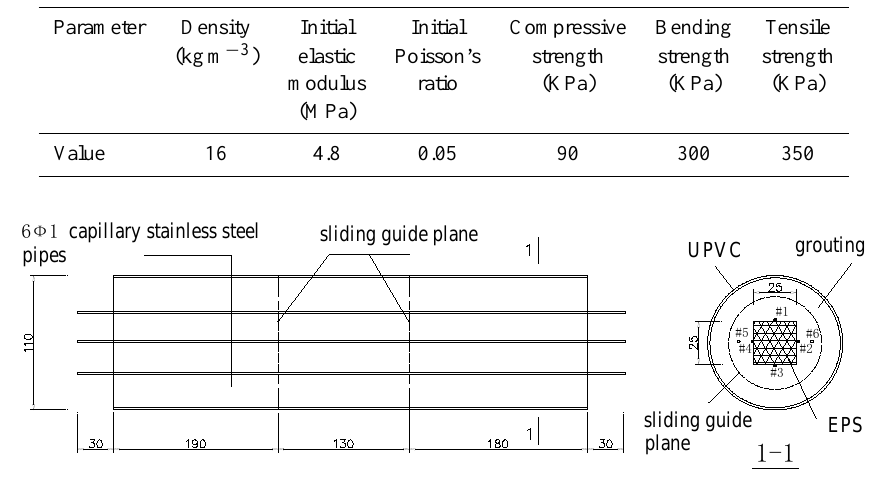
Figure 1. Double shearing test model (unit: